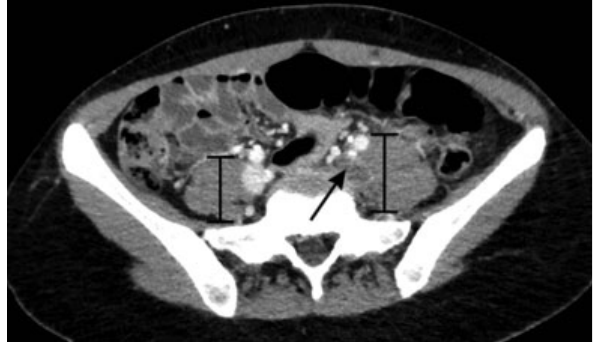
Fig. 1 Postcontrast axial view of CT of abdomen/pelvis demonstrating a clotwithintheleftcommoniliacvein( arrow )andthecomparativeincreased size of the underlying psoas muscle ( brackets